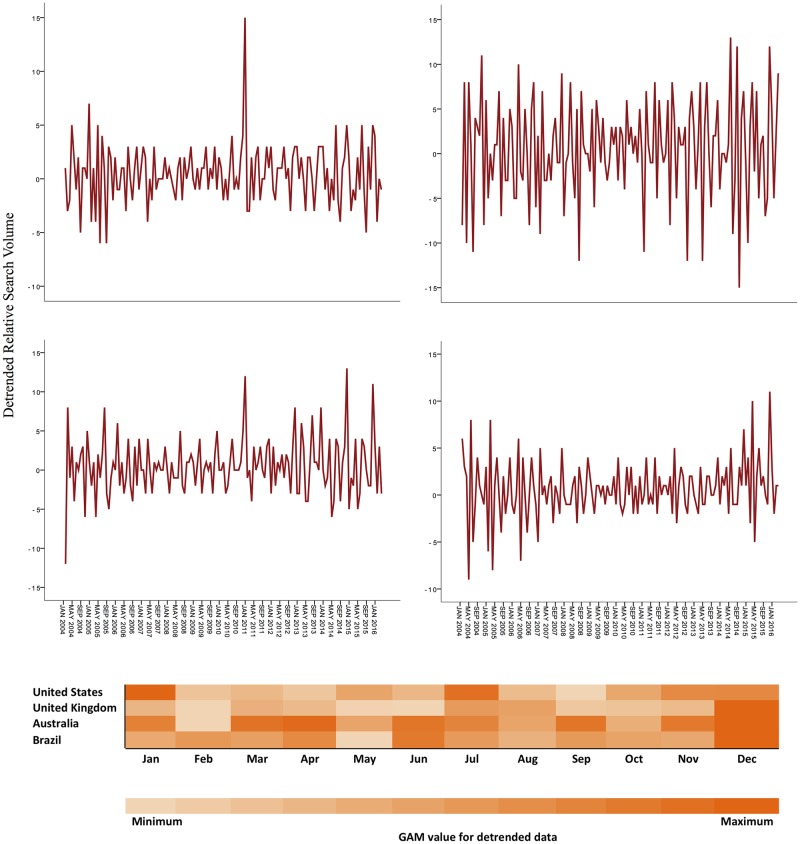
Seasonality of the interests of Google users on toothache.It was estimated by fitting a generalized additive model (GAM) to the detrended Google Trends data (lag-1 difference). Note that the scales vary from negative to positive values, since they represent the variation of values of the RSV of a month minus the RSV of the previous month. For instance, the detrended value of December 2004 is represented by the difference of its RSV in relation to the RSV of November 2004. GAM values using monthly RSV as a predictive variable for Google data are represented in the heat map.